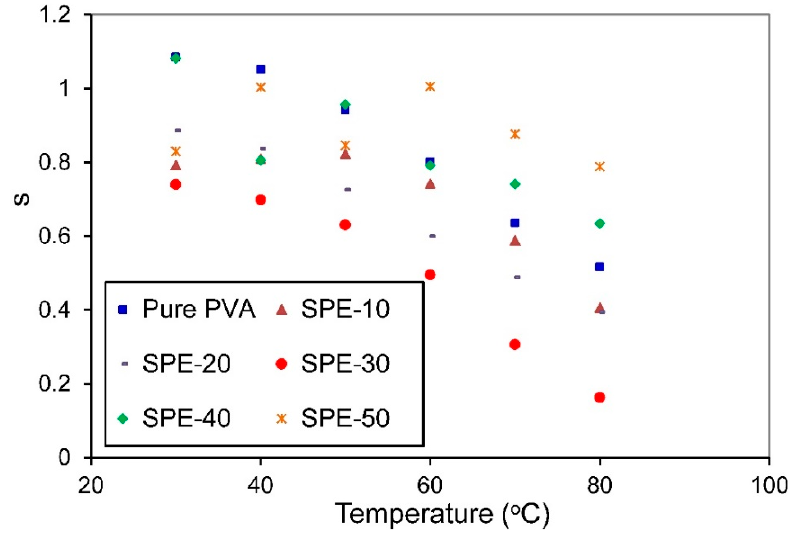
Figure 7. Variation of exponent 𝑆 with temperature for PVA/NH 4 NO 3 proton-conducting SPE films with different concentrations of NH 4 NO 3 .